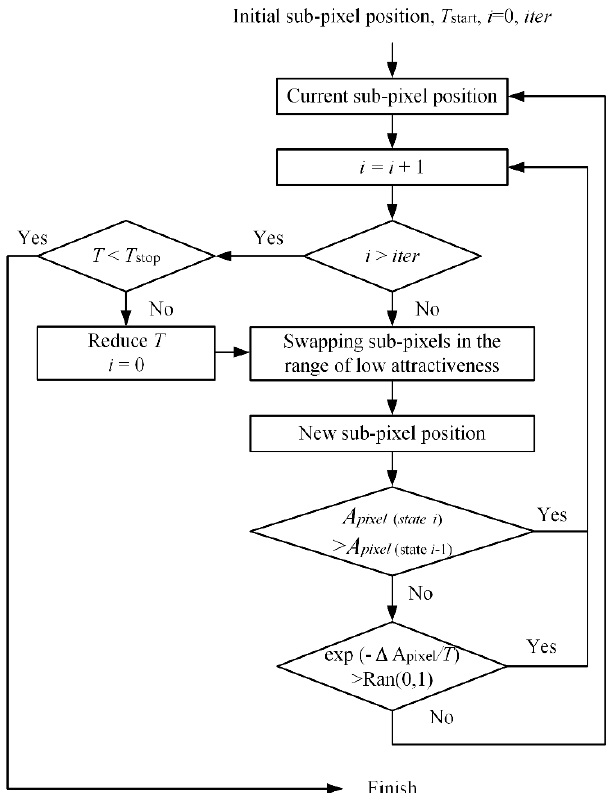
Figure 3. Flow chart of the modified simulated annealing algorithm.